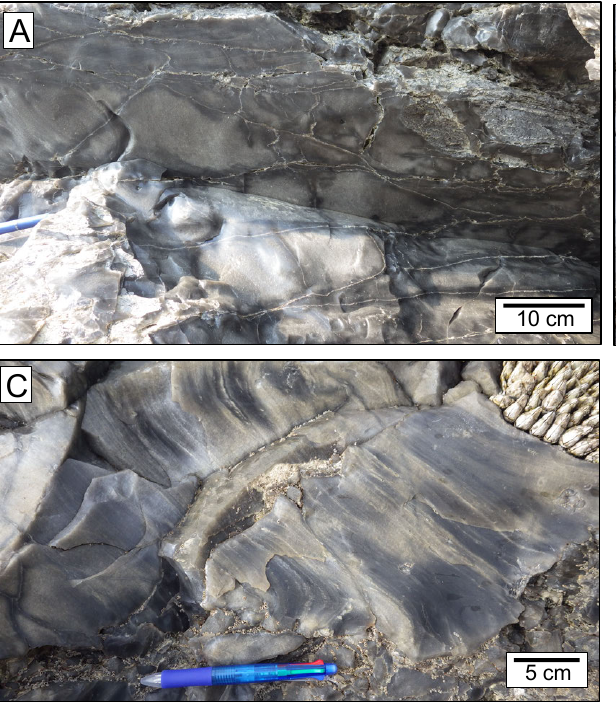
Fig. 9 Furukawa et al.